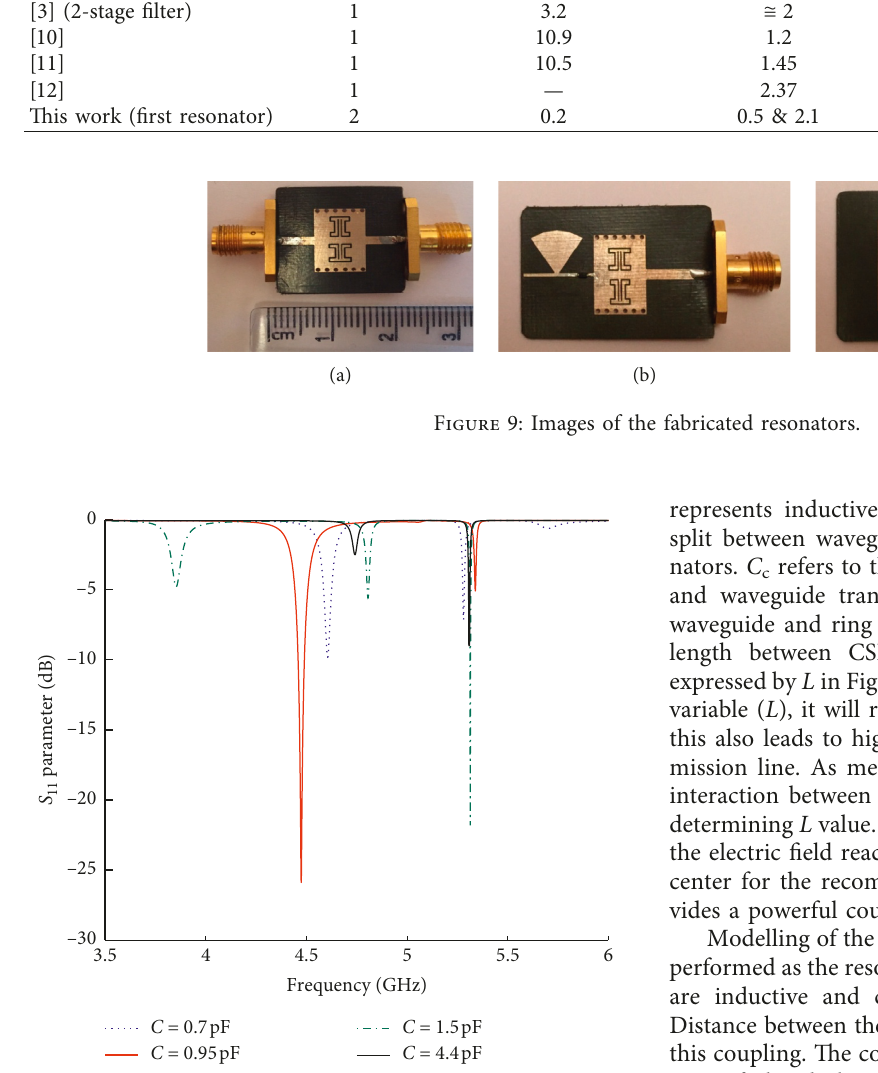
Figure 10: Frequency response variations of the second proposed resonator versus frequency for various values of the varactor diode capacitance. The geometrical parameters are L � 2.2mm, � 3.6mm, a � 3.6mm, a � 1.8mm, a � 1.2mm, g � 0.2 mm, a 1 2 3 4 and a 5 � 3.1mm for the upper CSRR and L � 2.4mm, g � 0.2mm, a 1 � 3.2mm, a 2 � 4 mm, a 3 � 2mm, a 4 � 0.9mm, and a 5 � 3.5mm for the lower CSRR and W � 11.5 mm and t �